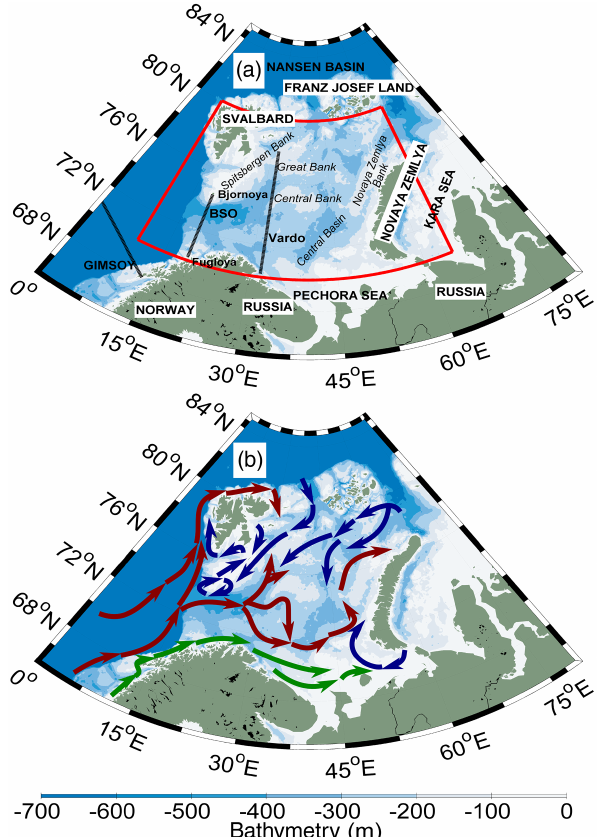
Figure 1. (a) Barents Sea map with bathymetry. The red line de- limits the studied area. Repeated sections are represented in dashed black line: GIMSOY, BSO (Barents Sea Opening) and Vardø. (b) Schematic surface circulation of the main water masses (Atlantic Water: red arrows; Arctic Water: blue arrows; Norwegian Coastal Current: green arrows) (adapted from Harris et al.,